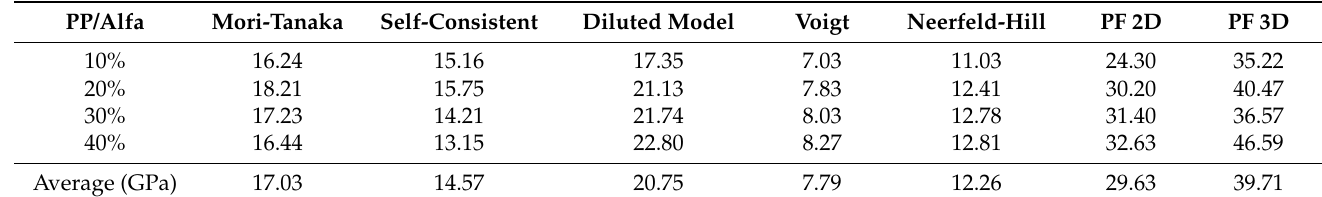
Table 1. Results of the reverse approach for all of the studied homogenization methods.